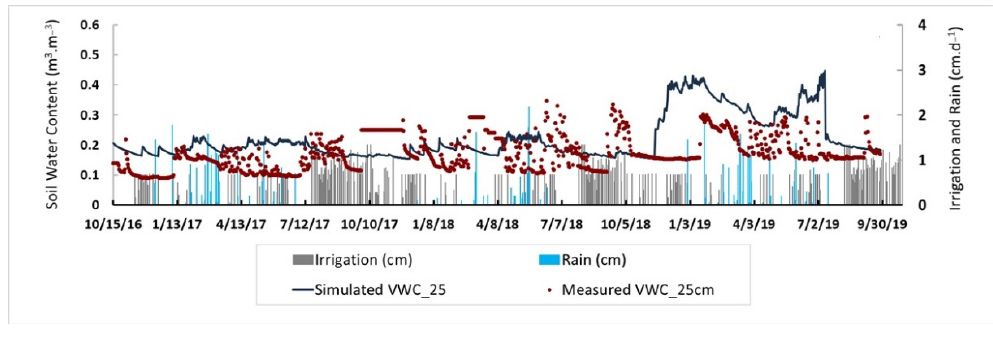
Figure 5. Effects of irrigation and rain on the measured and HYDRUS-1D simulated soil water contents at a depth of 25 cm at the ASM site.